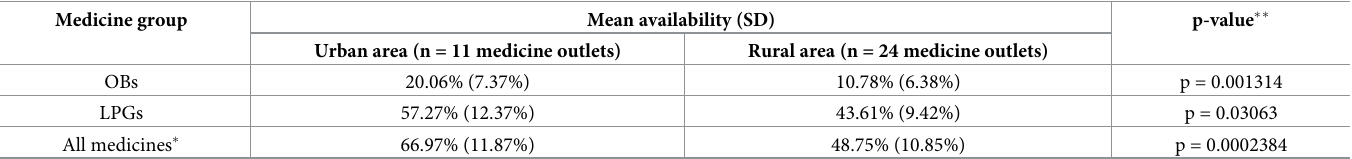
Table 4. Private sector: Comparison of the mean availability of EMs between urban and rural